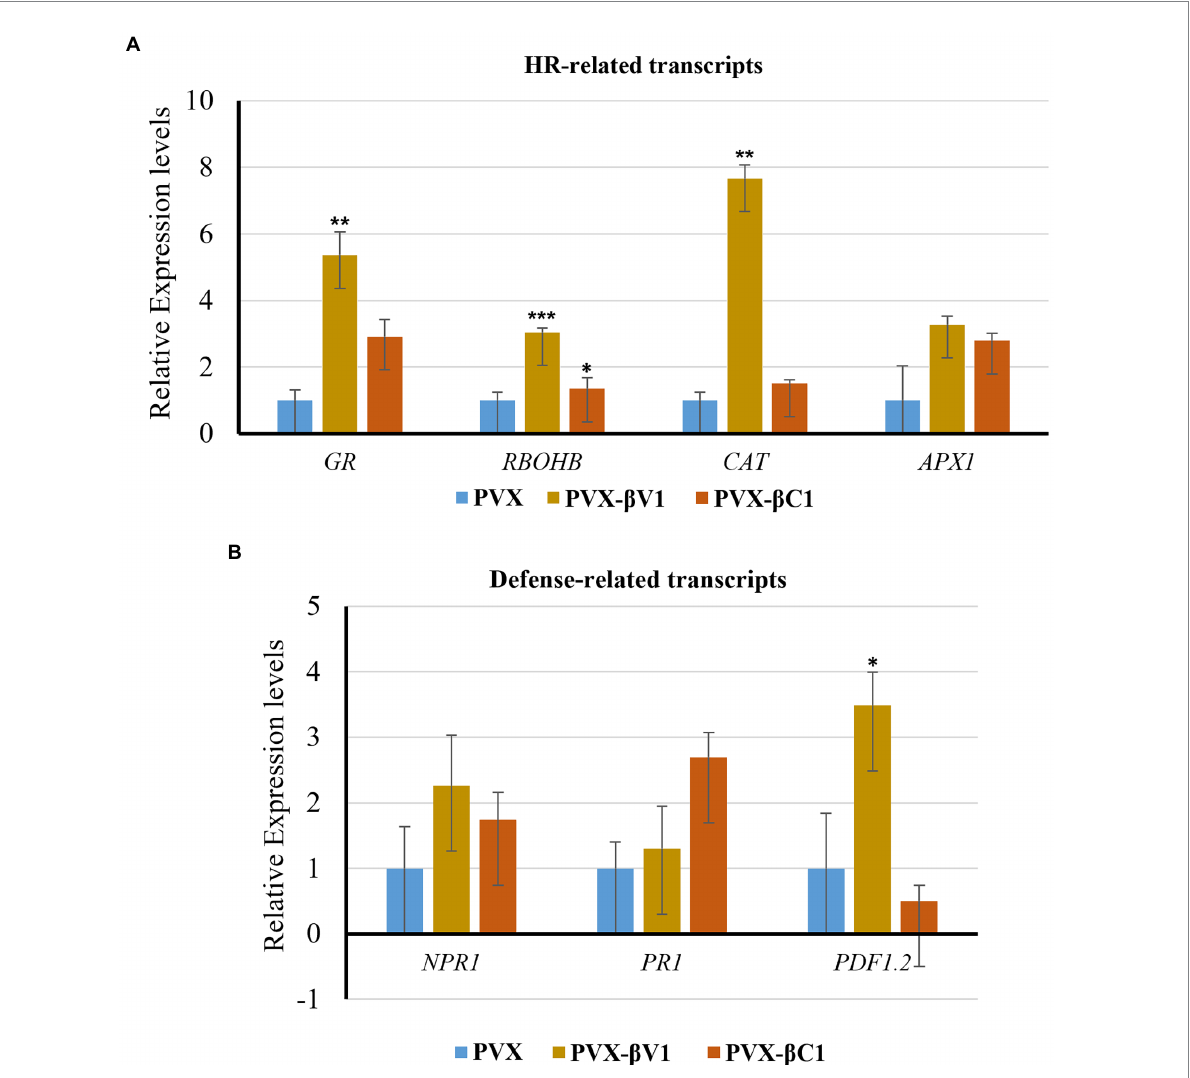
FIGURE 3 Transcript analysis through qRT-PCR. Relative expression levels of (A) HR-related transcripts ( RBOHB , CAT , GR , and APX1 ), and (B) defense-related transcripts ( NPR1 , PR1 , and PDF1.2 ) in N. benthamiana leaves infiltrated with PVX- β V1 and PVX- β C1 at 5 dpi. The PP2A gene was used as a reference control to normalize the transcripts. The error bar represents the standard error, and the asterisk on the top of the bars indicates a statistically significant